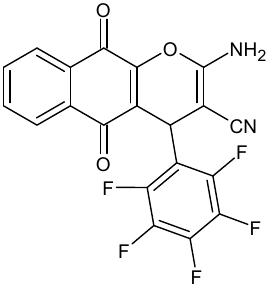
Figure 7. The structure of 2-amino-5,10-dihydro-5,10-dioxo-4-(2,3,4,5,6-pentafluorophenyl)-4H- naphtho[2,3-b]pyran-3-carbonitrile.